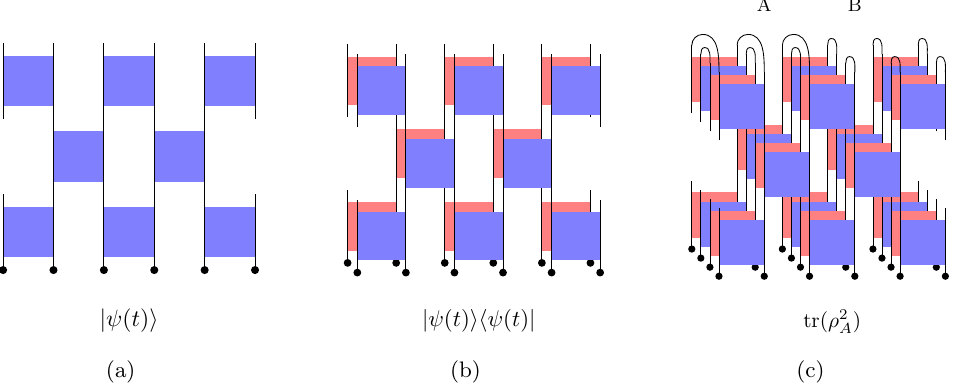
Figure 9 . Random unitary circuit: (a) its tensor network structure, where each blue block repre- sents a q q Haar random unitary matrix (b) the time dependent density matrix (c) computing (cid:2) tr ( (cid:26) n ) ; n = 2 by contracting di(cid:11)erent A